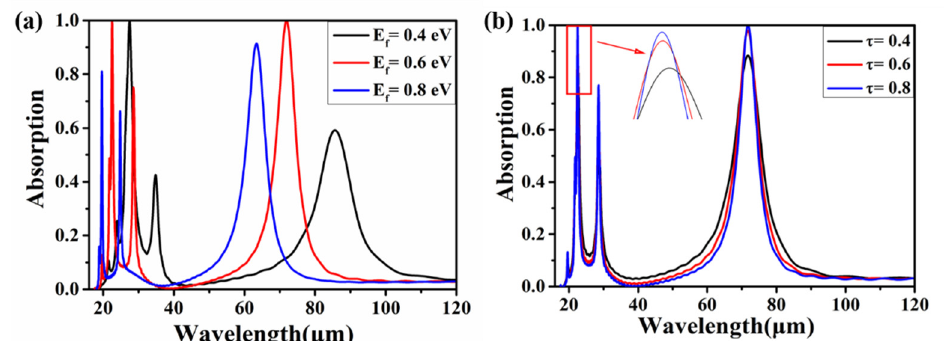
Figure 6. ( a ) Absorption spectra corresponding to different Fermi levels E f . ( b ) Absorption spectra corresponding to different relaxation times.